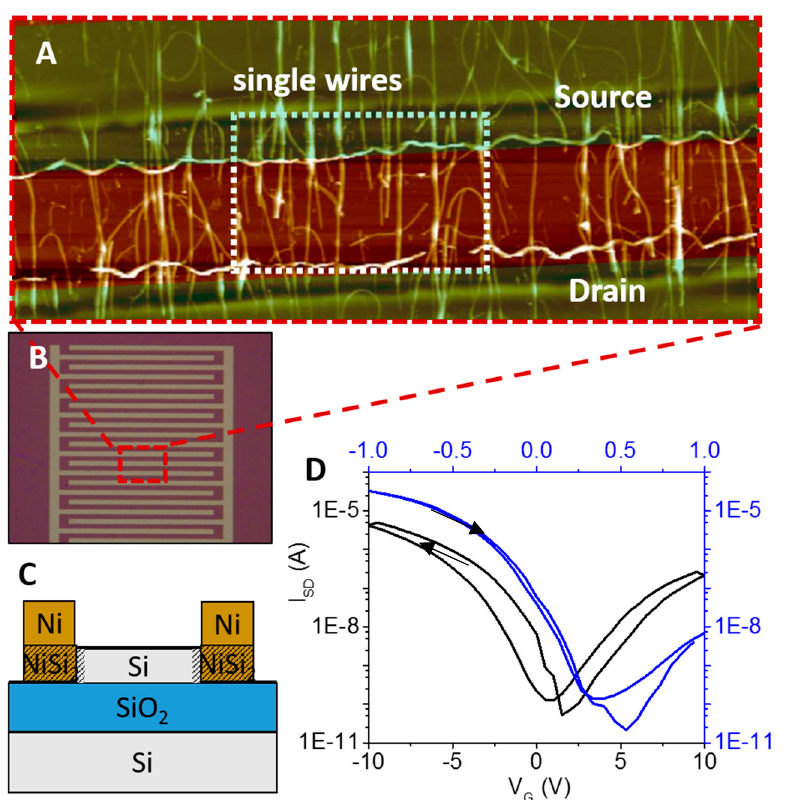
Figure 1. Representation of the sensor system. ( A ) AFM image of the silicon nanowire field effect transistors (FETs) with Schottky barriers. The electrodes offer multiple contact sites of the silico nanowires (SiNWs) to electrodes and create parallel arrays with numerous interconnections. ( B ) Interdigitated electrode design of the FETs. The red rectangle shows a magnification of the wire section. ( C ) Cross-section of the sensor. Nanowires are connected to electrodes via NiSi 2 and serve as Schottky junctions. By the Schottky junctions the sensitivity of the sensor is enhanced. ( D ) Transfer characteristics of the SiNW FETs. The black line shows the behavior in dry conditions, whereas the blue line refers to characteristics in liquid conditions. The arrows indicate the scan direction of applied potential scan.